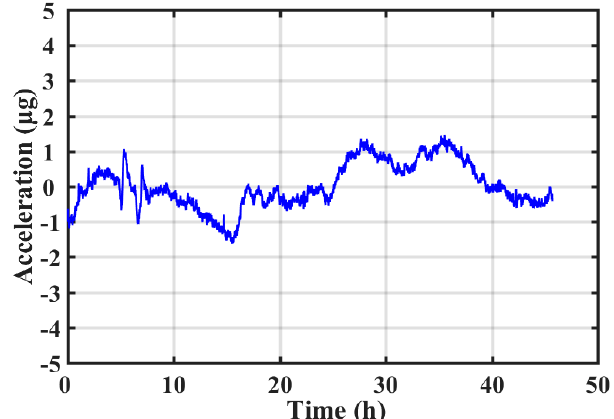
Figure 13. Stability of the MEMS accelerometer with thermal effect deducted and offset removed.